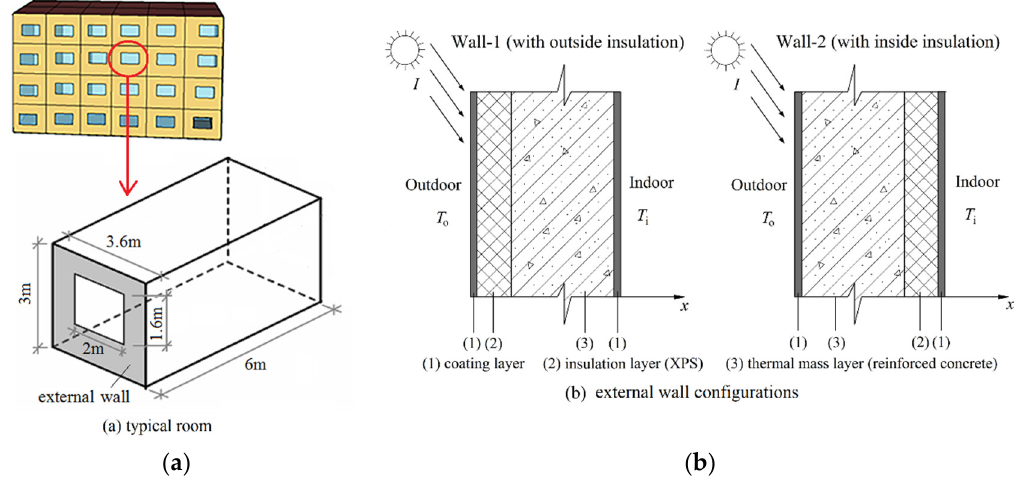
Figure 3. Schematic view of the ( a ) typical room; and ( b ) external wall configurations.